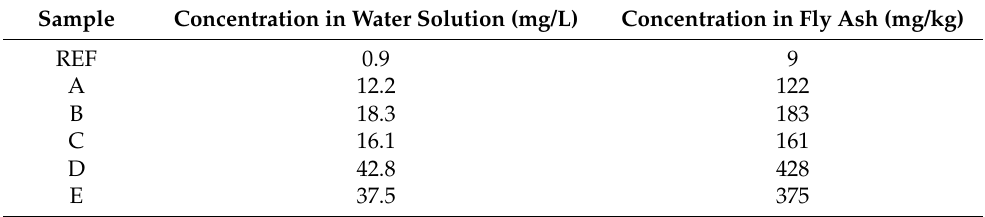
Table 1. Ammonia content in the tested fly ash (A–E—samples from denitrification process).